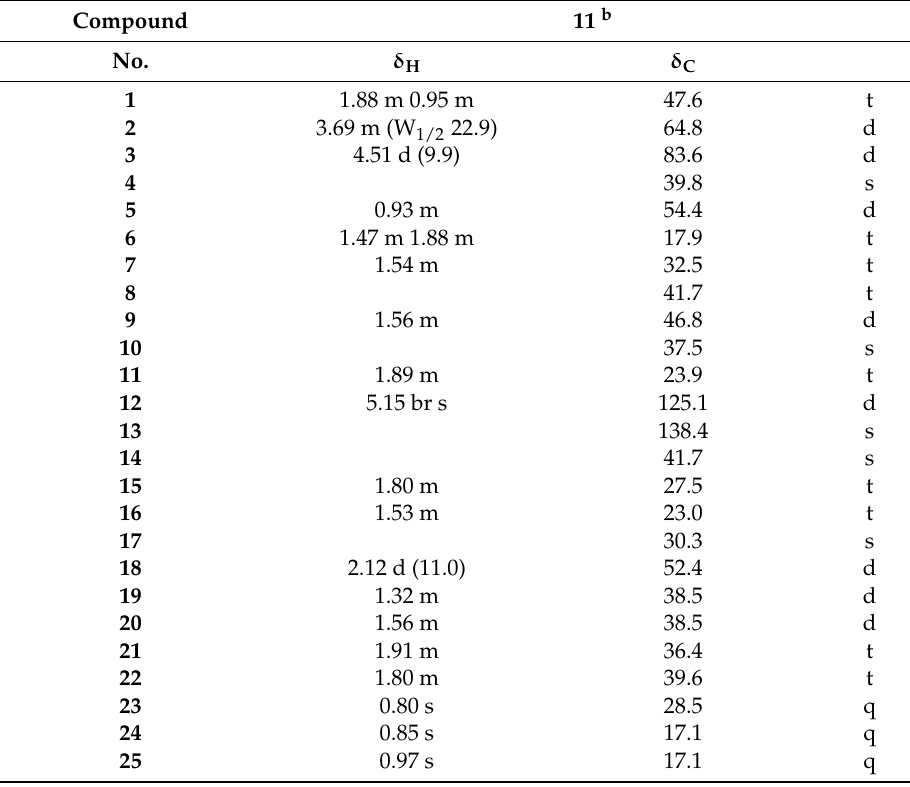
Table 2. 1 H- and 13 C-NMR spectroscopic data for compound 11 a ( δ in ppm, DMSO, J in Hz).